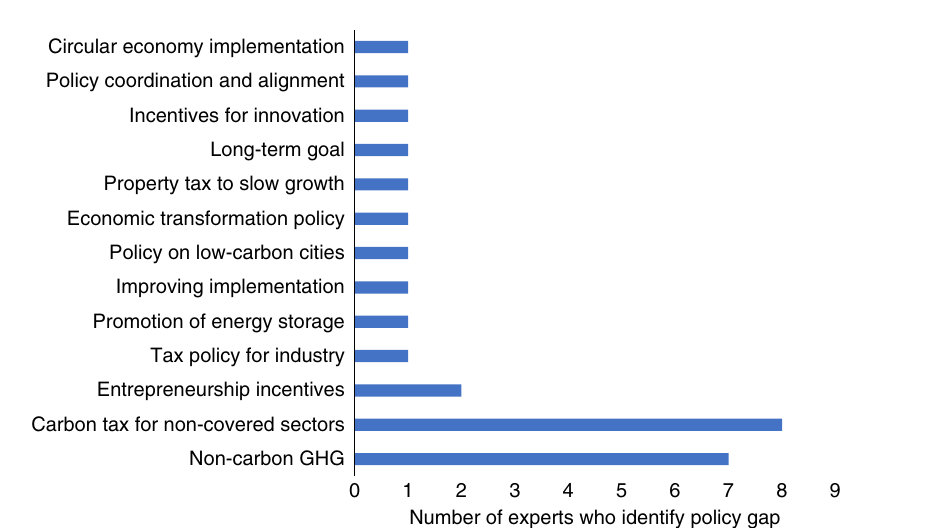
Fig. 3 New policies needed to close the climate policy gap in China. GHG refers to greenhouse gas. Carbon tax for non-covered sectors and non-carbon GHG (e.g., CH4) are recognized as the two most important new policies needed. Notably, there is little consensus on the magnitude of other kinds of new policies that are needed to close the climate policy gap in